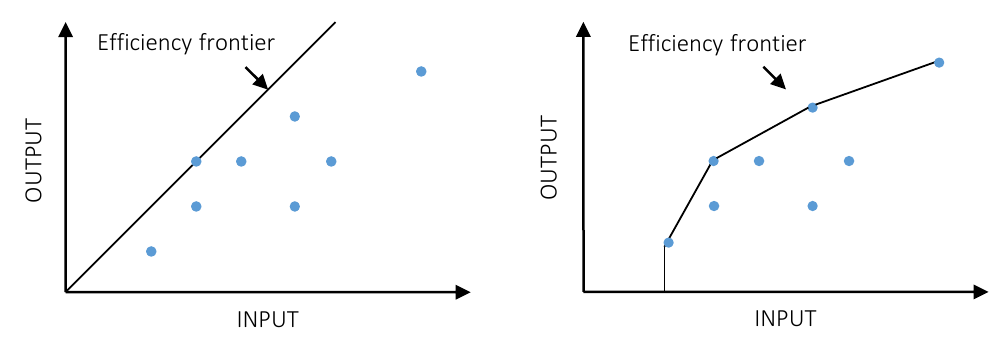
Figure 3. Graphical representation of the CCR and BCC